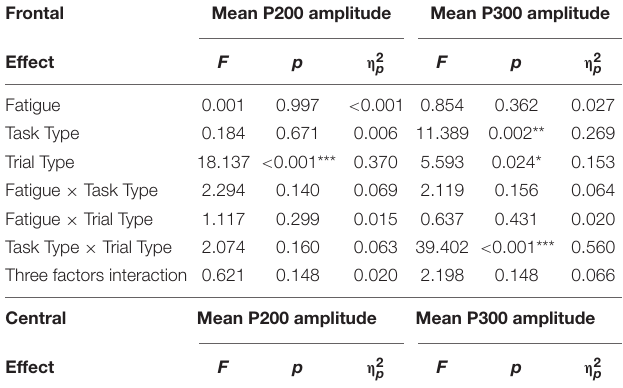
= 0.454]. And the amplitude in post-interruption p < 0.001, η 2 p trials was higher than in pre-interruption trials. Further simple effects analysis shows that the amplitude difference by trial type was noted only in IT condition [ F (1, 32) = 42.531, p < 0.001, η 2 = 0.571], but not in ST condition [ F (1, 32) = 0.968, p = p